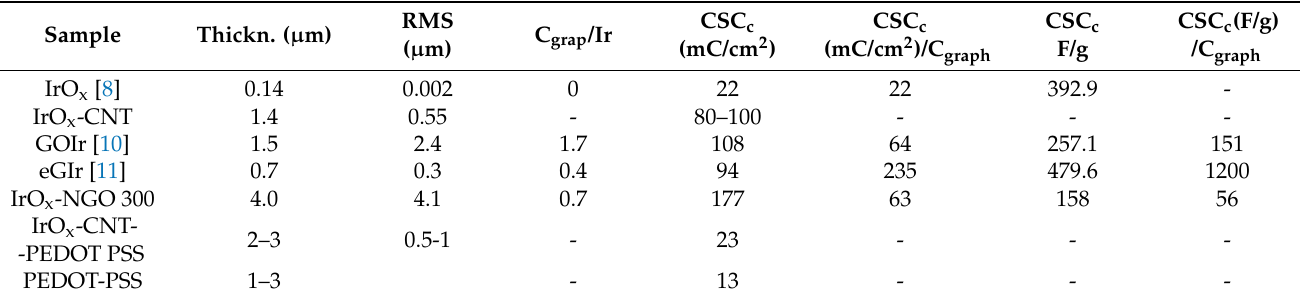
Table 2. Thickness, roughness and charge capacities for each hybrid, vs. pure IrO x and other materials.